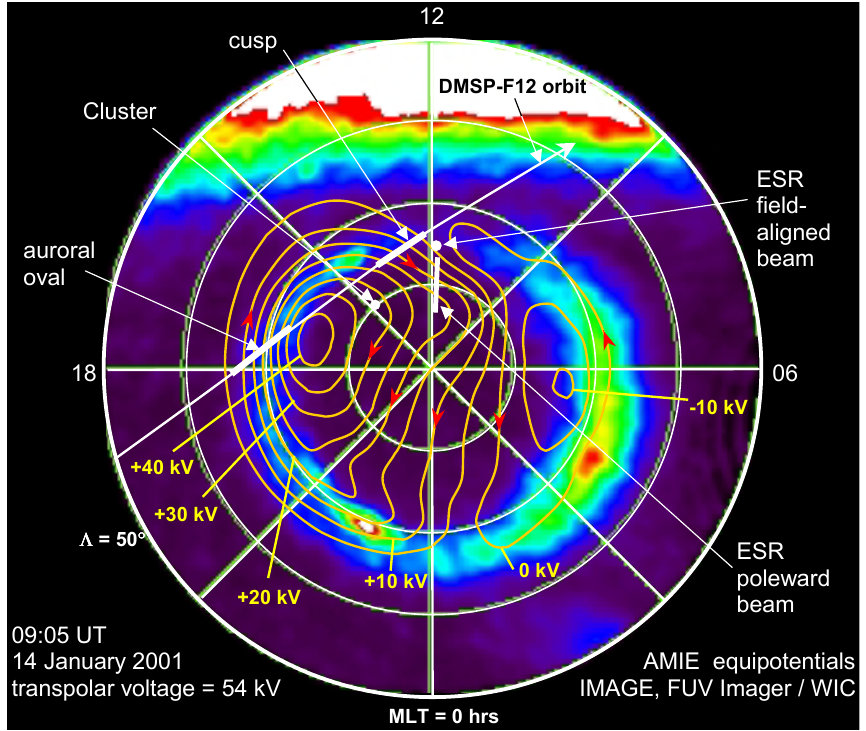
Fig. 1. The locations of the coordinated measurements on 14January2001 in an invariant latitude ( 3 ), with magnetic local time (MLT) frame at 09:05 (the time of the closest approach of the DMSP-F12 satellite to the ESR field-aligned beam). The footprint of the centroid of the Cluster tetrahedron is mapped down to the northern hemisphere ionosphere using the Tsyganenko T96 model with average input parameters for the interval studied here (see text for details). The plot also shows in white the locations of the two beams employed by the EISCAT Svalbard Radar (ESR) on this day. The pass of the DMSP-F12 satellite at 08:54–09:12UT is shown, with thicker segments denoting where the satellite intersected the dusk auroral oval and the cusp. The orange contours are convection equipotentials, derived by the AMIE technique employing magnetometer, SuperDARN, DMSP and ESR observations. These are superposed on observations of auroral emissions made at this time by the WIC of the FUV imager on the IMAGE